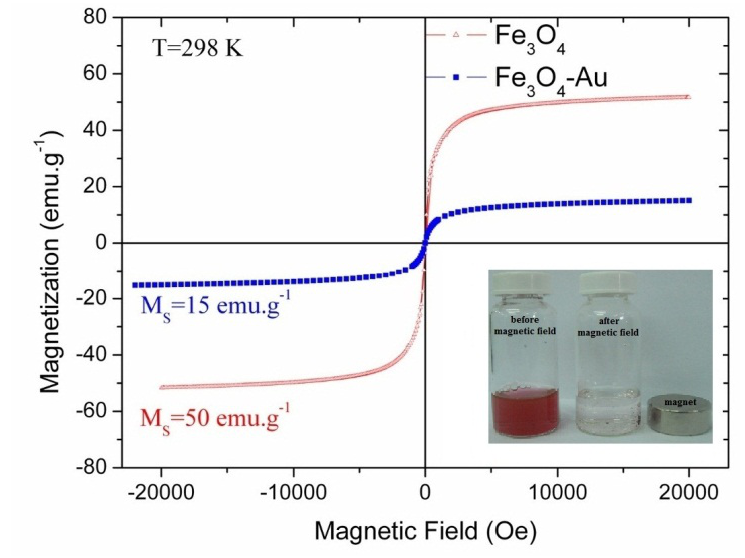
Figure 3. Magnetic field dependence of magnetic particles and inset: Photographs of magnetic gold nanosphere before and after applying magnetic